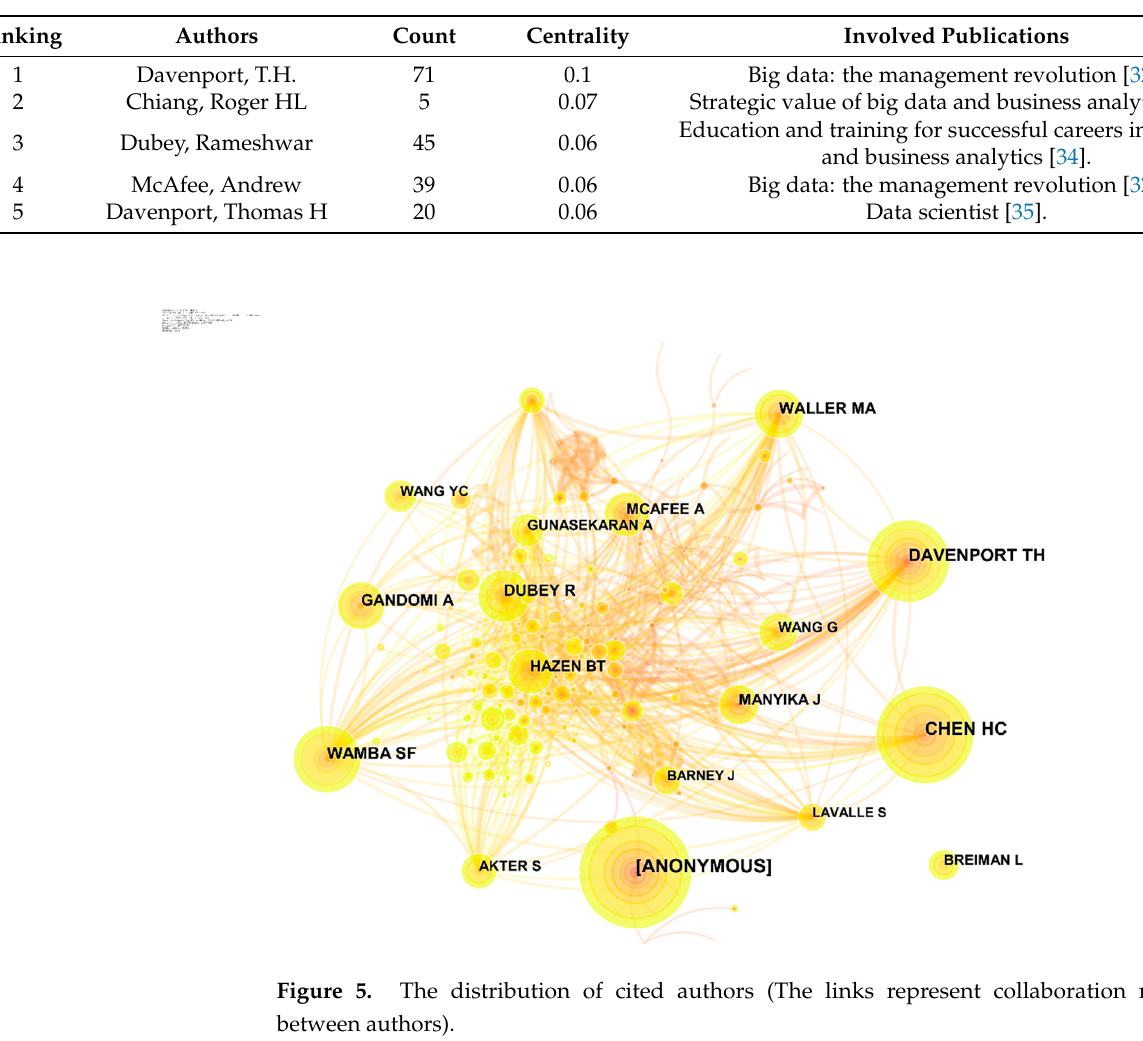
Table 4. Top 5 authors according to the centrality.